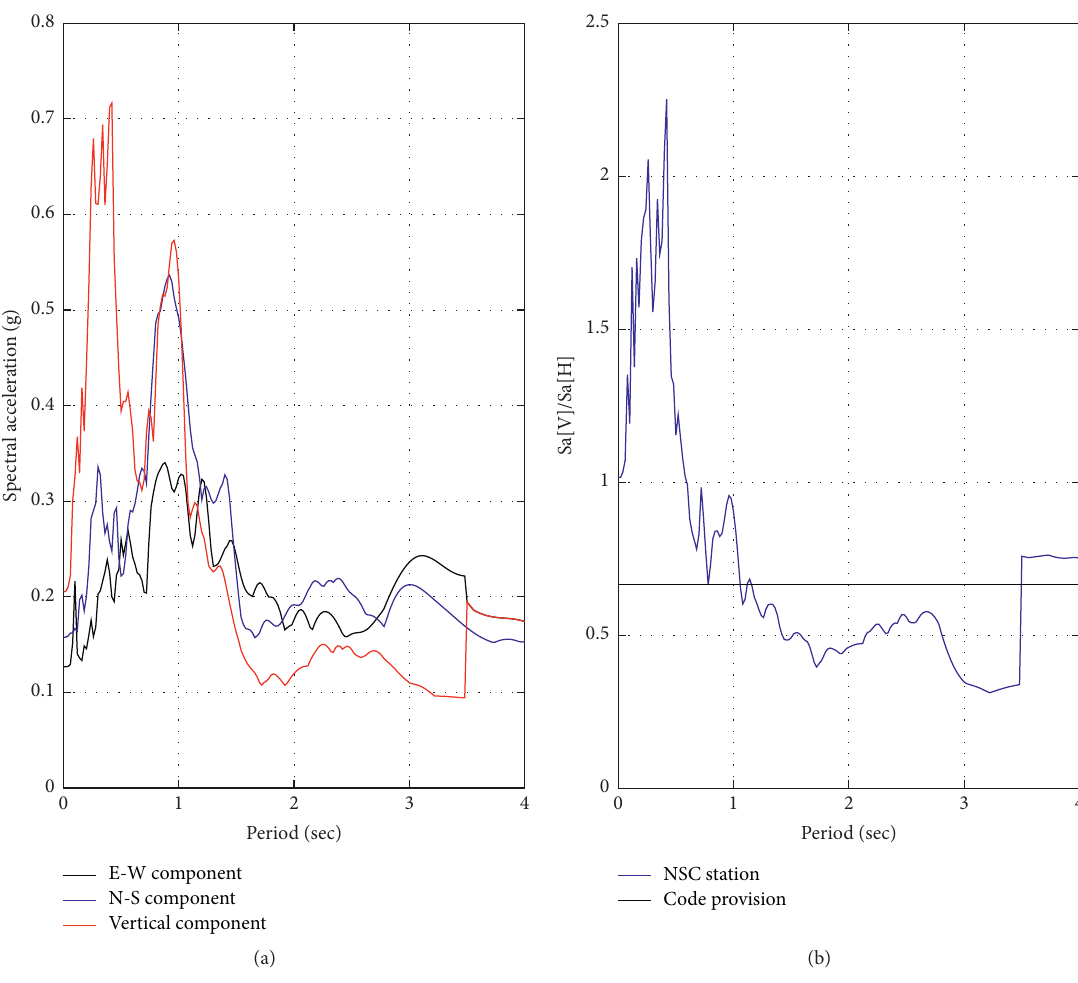
Figure 2: (a) Acceleration response spectra of the 2015 Gorkha earthquake recorded by National Seismological Center (NSC) [117] and (b) vertical to horizontal spectral ratio for the Gorkha